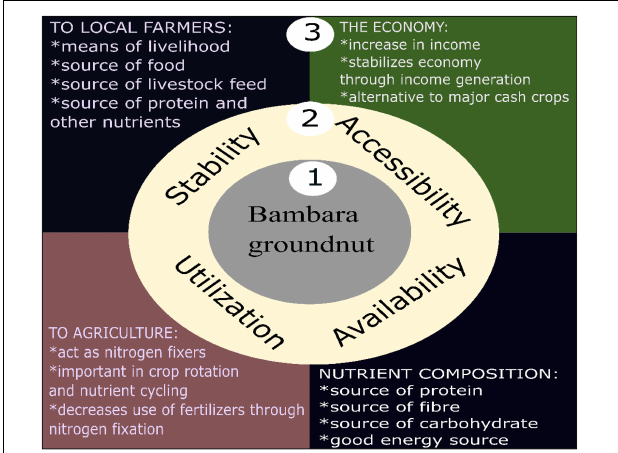
FIGURE 1 | Aligning BGN with the SDG goals. The relationship of Bambara groundnut (1) to the four pillars of food security (2) and the importance of this crop to farmers, agriculture, the economy, and its nutrient composition